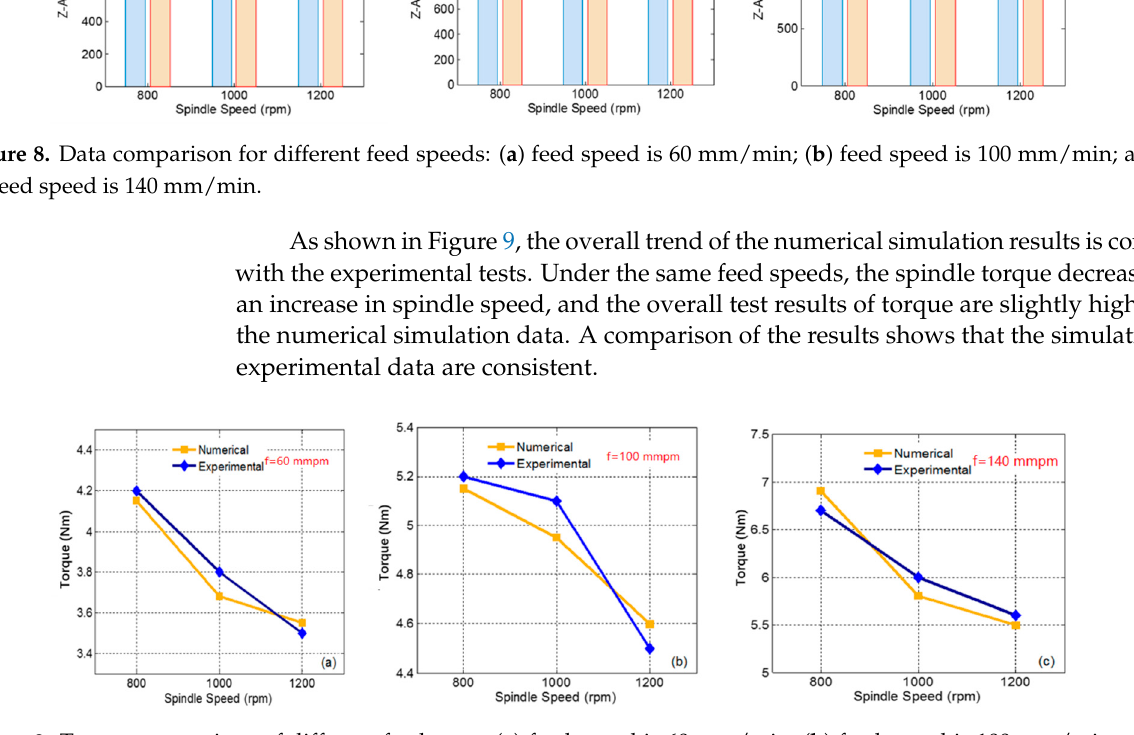
Figure 9. Torque comparison of different feed rates: ( a ) feed speed is 60 mm/min; ( b ) feed speed is 100 mm/min; and ( c ) feed speed is 140 mm/min.